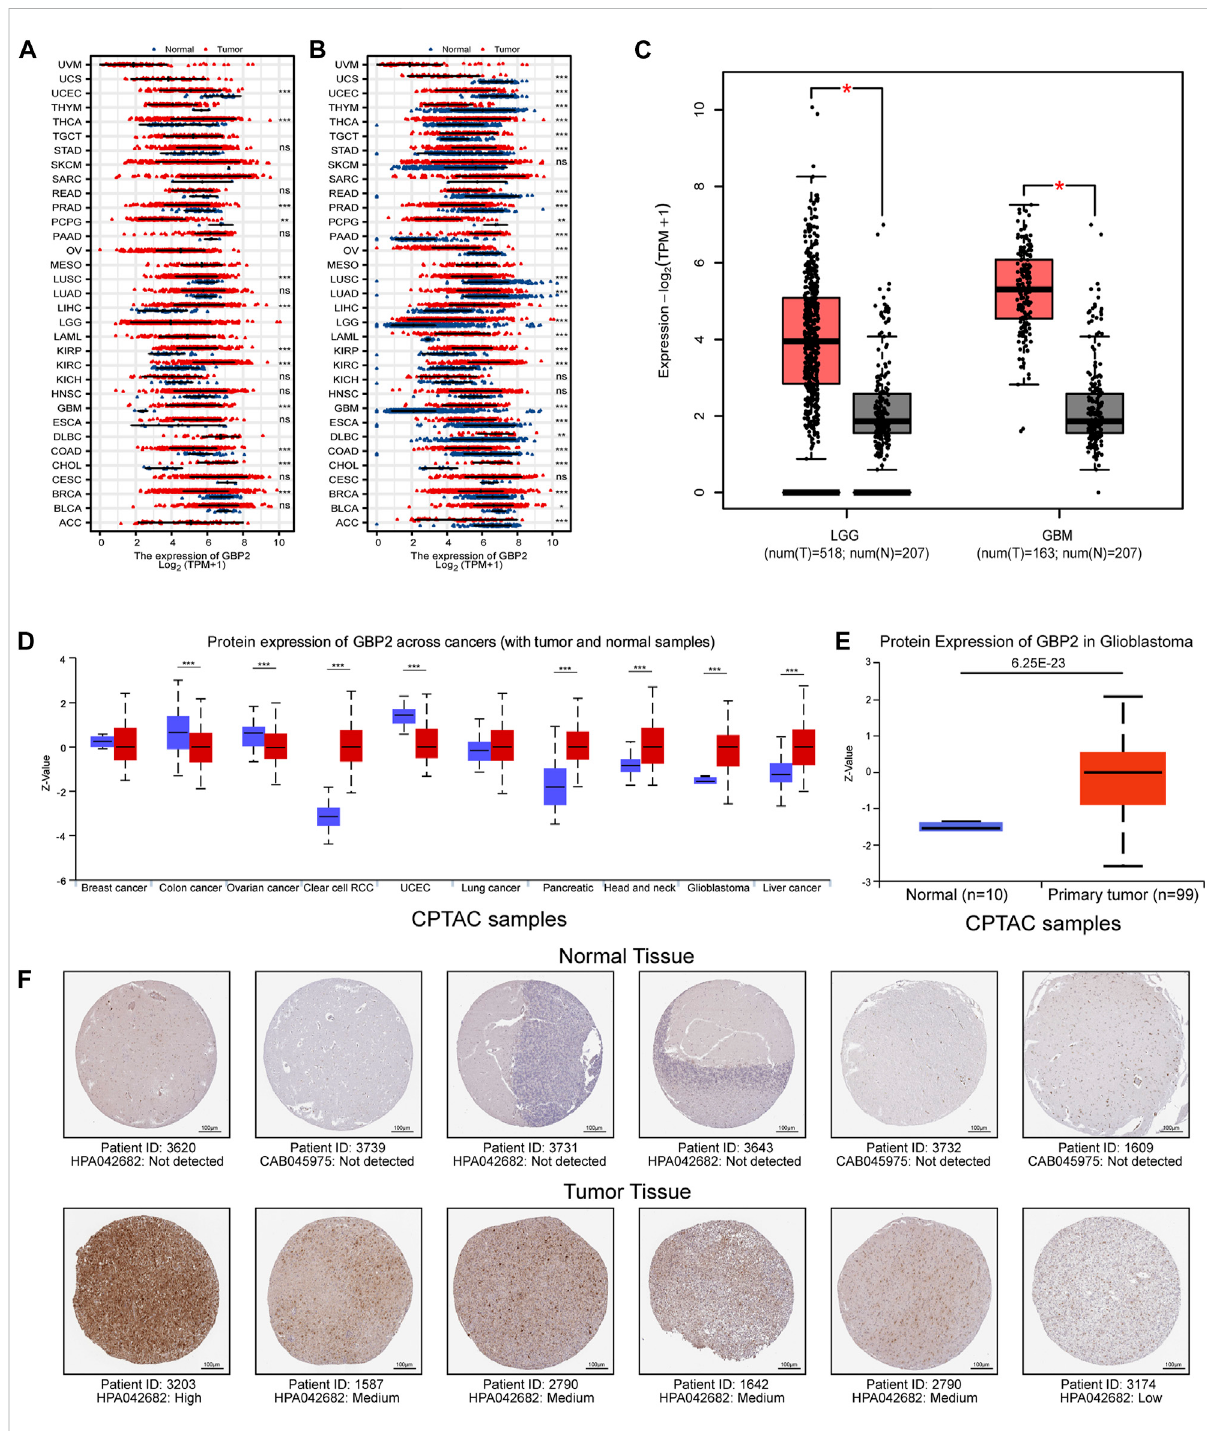
FIGURE 1 GBP2 was highly expressed at different levels in glioma. (A) GBP2 expression in GTEx normal tissue and TCGA tumor tissue at RNA level. (B) GBP2expressionbetweenTCGAtumortissueandTCGAadjacentnormaltissueatRNAlevel.Ns, p ≥ 0.05;* p < 0.05;** p < 0.01;*** p < 0.001. (C) The RNAlevels of GBP2 between tumors and normal samplesinLGG and GBMsamples(GEPIA database). The redasterisk meansthe p -value isless than 0.01. (D) The protein level of GBP2 between tumors and normal tissue across cancer types in Ualcan database. (E) The protein level of GBP2 between glioma and normal samples in Ualcan database. (F) Immunohistochemistry was used to validate the high protein levels of GBP2 in glioma tissues (HPA database). * p <